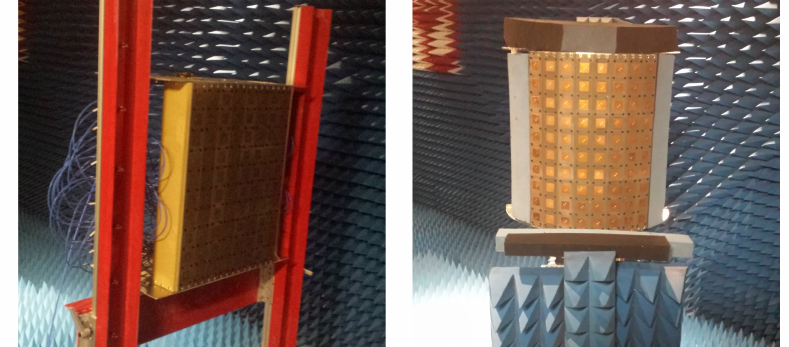
Figure 9. Measurement setup for 10-by-eight planar ( left ) and cylindrical ( right ) phased array